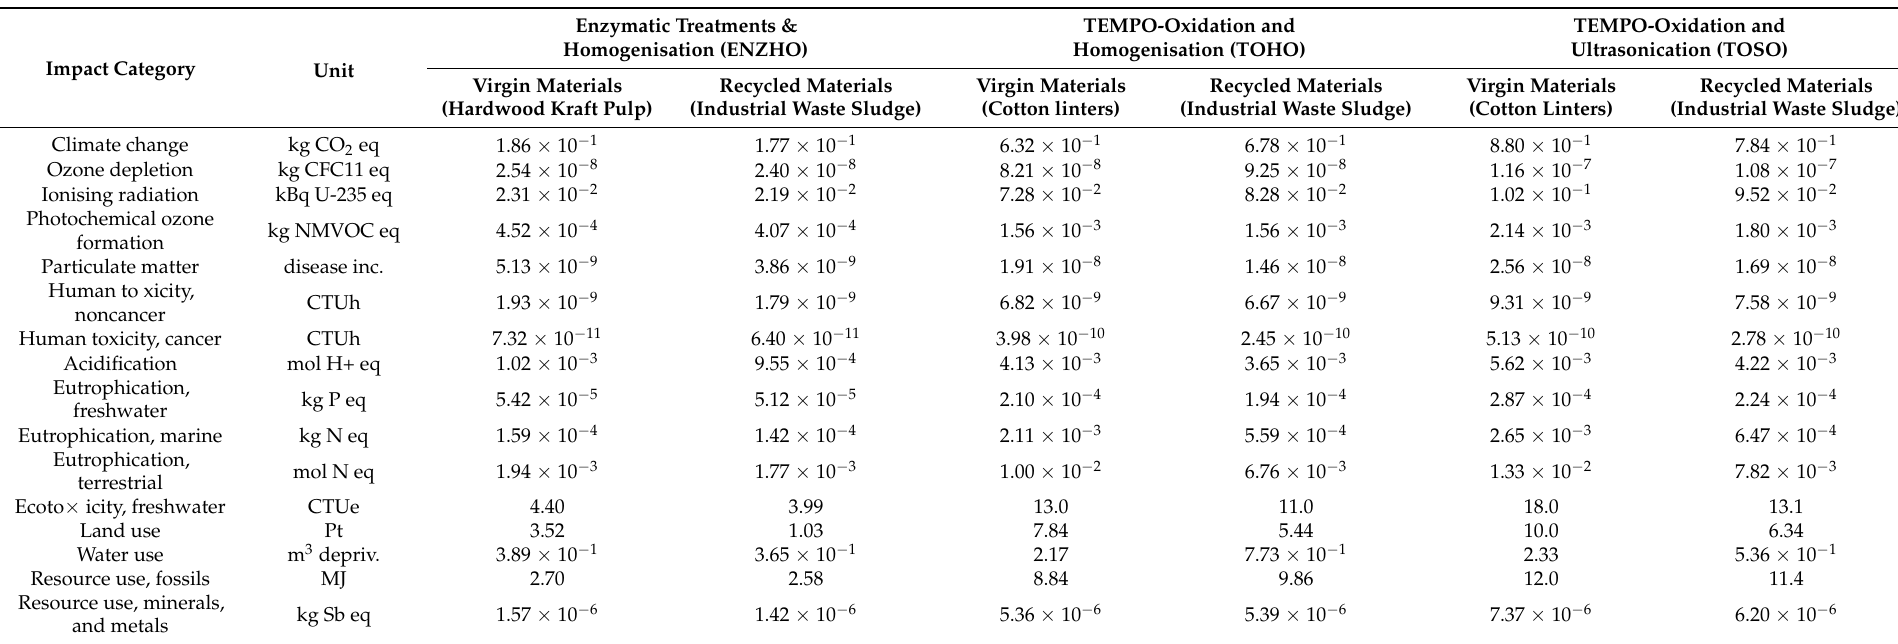
Table 1. Life cycle impact assessment of the six CNFs produced at the lab scale; the results are given per FU and refer to the characterisation